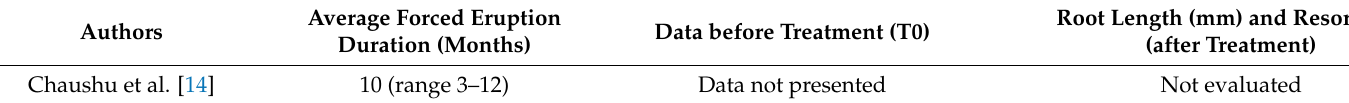
Table 3. Summary of the results of the included studies (forced eruption duration and root